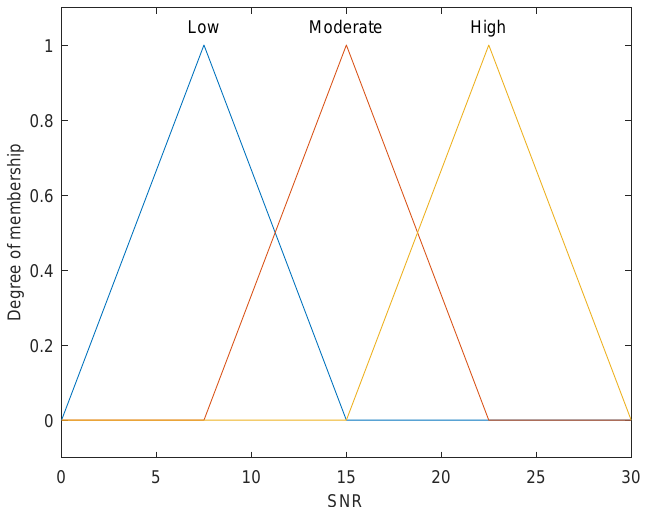
Figure 4. Membership function (MF) plot for input variable ( SNR